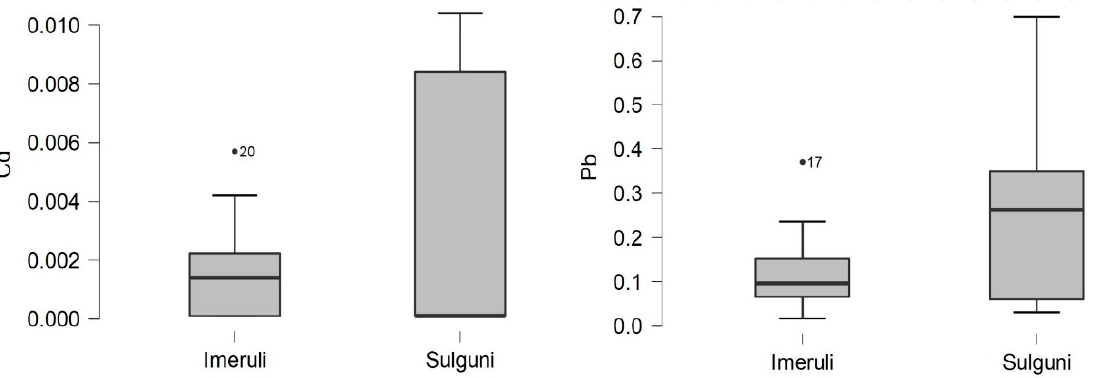
Figure 2. The cadmium (Cd) and lead (Pb) content of Imeruli and Sulguni cheese samples (mg/kg ww).